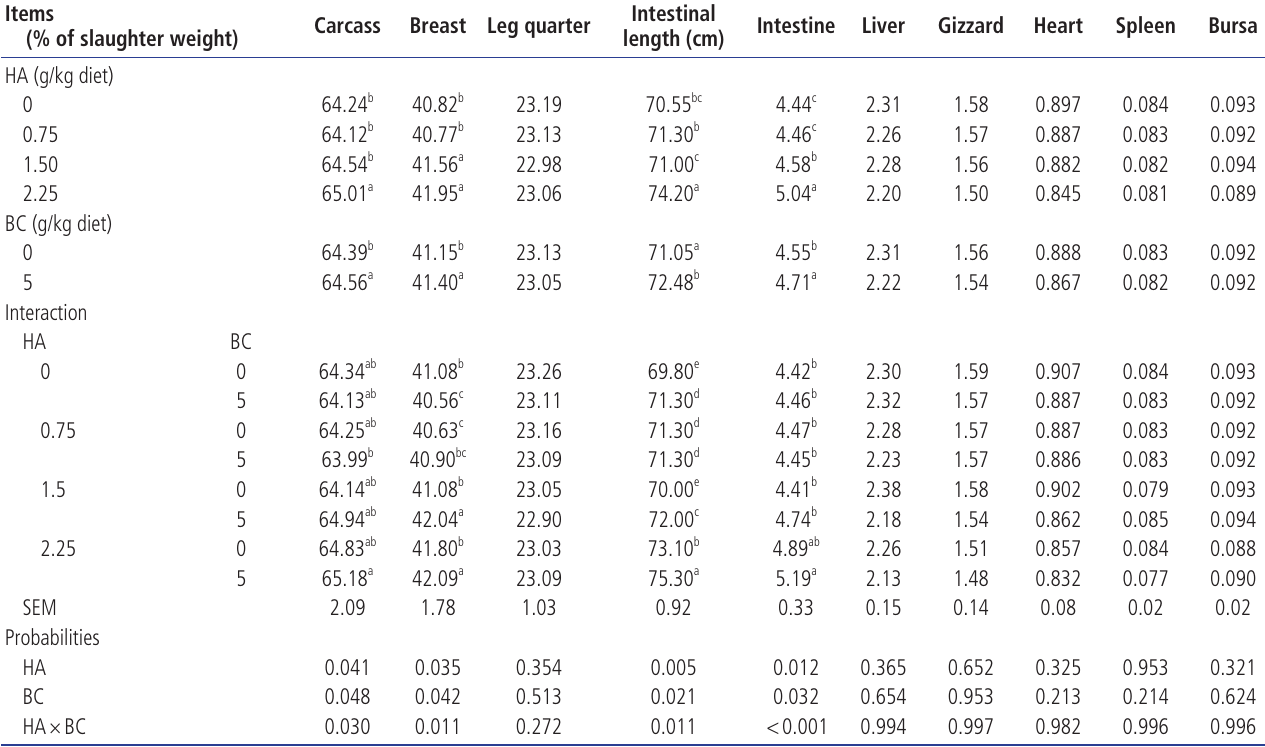
Table 3. Effect of dietary treatments on carcass characteristics and visceral organs (% of slaughter weight) of quail Items (% of slaughter